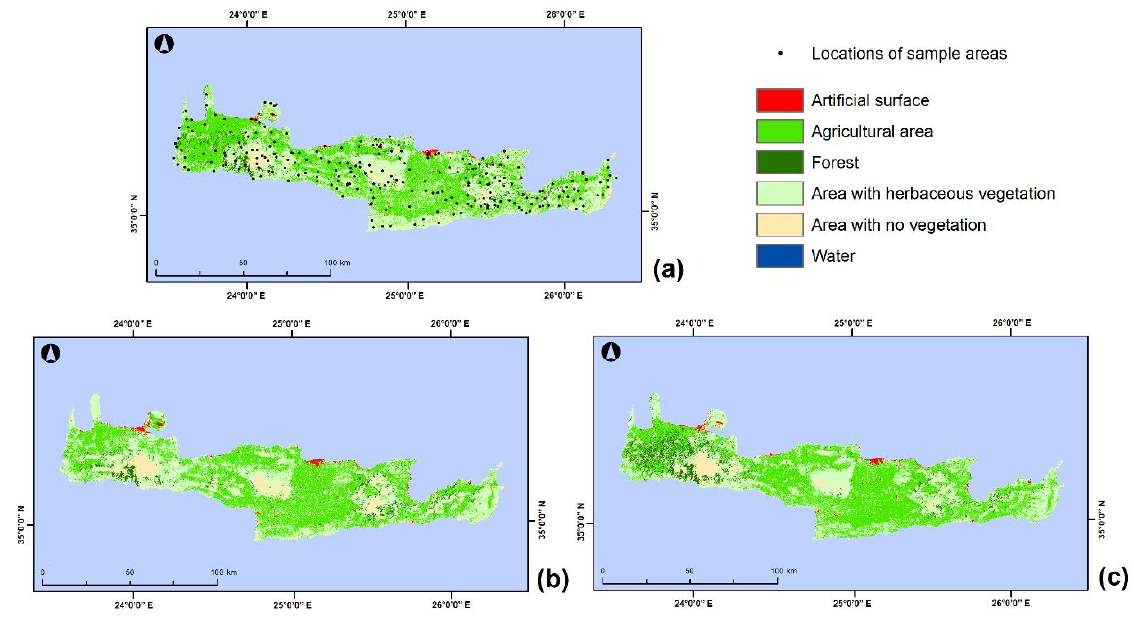
Figure 10. Detailed land cover maps produced by supervised classification: ( a ) 1999, including the locations of 246 sample areas represented by point features; ( b ) 2009; ( c ) 2019. Table 2. Kappa index and overall accuracy values calculated for different index combinations in two time periods.